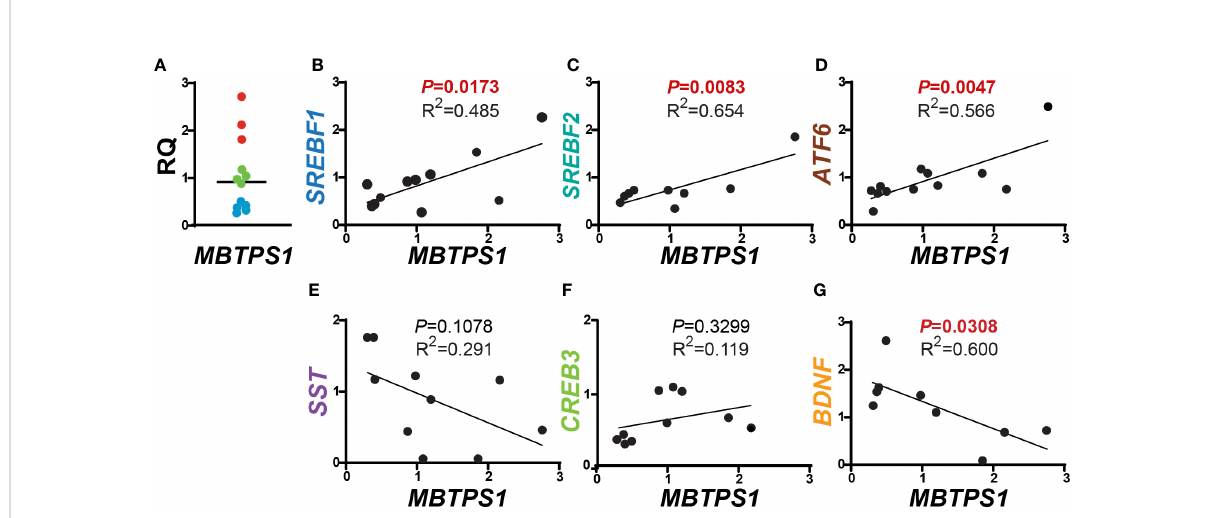
FIGURE 1 Correlations between MBTPS1 levels and its downstream targets in human CRC. (A) Relative MBTPS1 mRNA levels in tumors compared to normal surrounding tissue obtained from the same patient ( n =12 patients). Note that while in some patients the levels of MBTPS1 are unchanged (green circles), in others the levels are markedly elevated (red circles) or markedly reduced (light blue circles). (B – D) Positive correlation between MBTPS1 and three MBTPS1 targets: SREBF1 (r = 0.6963, P = 0.0173), SREBF2 (r = 0.8086, P =0.0083) and ATF6 (r = 0.7526, P = 0.0047). (E, F) No correlation between MBTPS1 and SST (r = -0.5691, P = 0.1078) or CREB3 (r = 0.3443, P = 0.3299). (G) A negative correlation between MBTPS1 and BDNF (r = -0.7138, P =